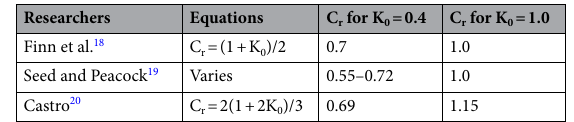
Table 3. Values of correction factor C r by earlier researchers.